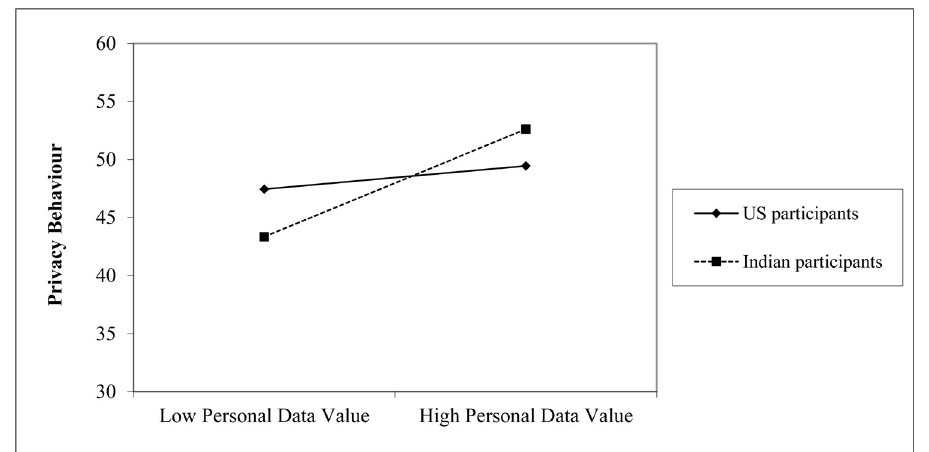
Fig 1. Simple slopes of personal data value by country. Points plotted on the x-axis are one SD above and below the mean.